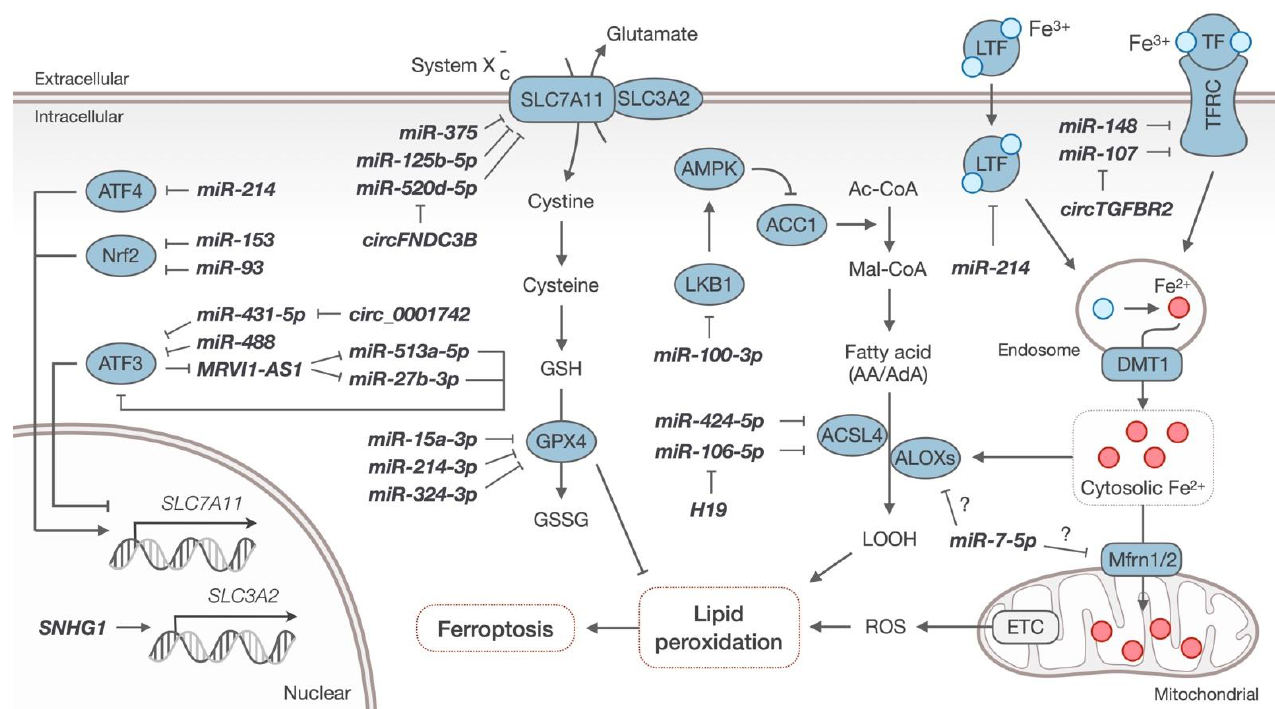
Figure 1. Roles and functions of the listed ncRNAs in the regulation of ferroptosis in head and neck cancers.